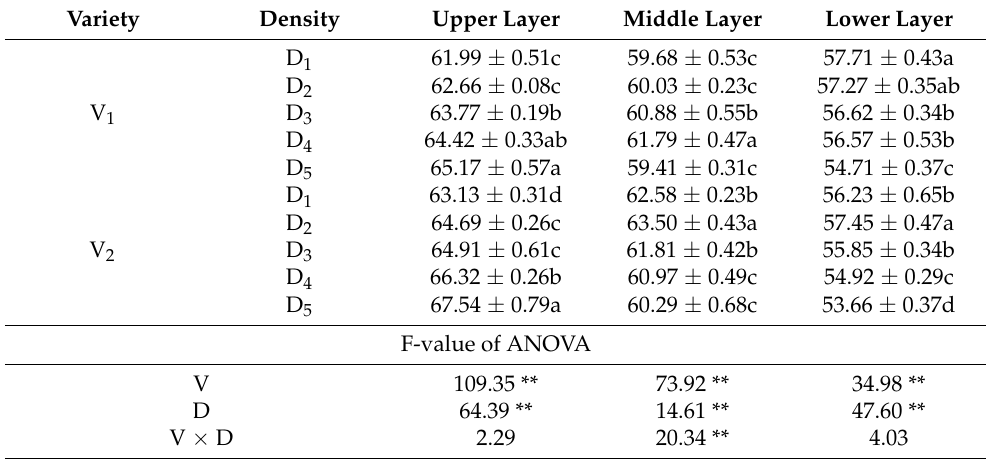
Table 2. Effects of planting density on the mean leaf tilt angle of winter wheat (mean ± SD). Variety